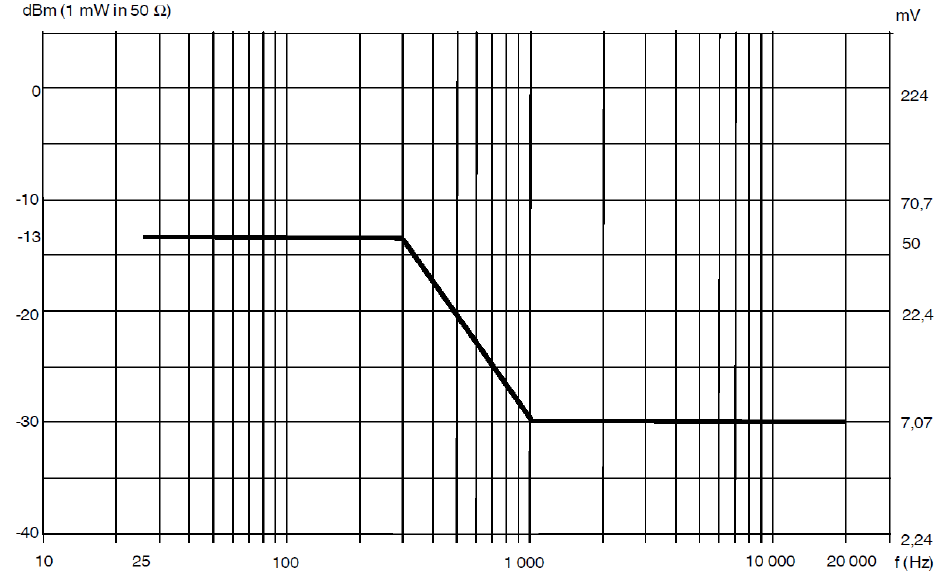
Figure 9. Profile of harmonic and supraharmonic levels of immunity for telecommunications and data centers, –48 Vdc (EN 300 132-2 [111] © ETSI 2019. All rights reserved).